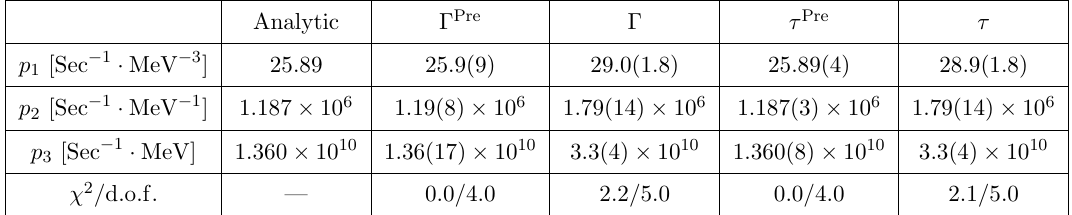
Table 23 . The analytic computations and (cid:12)tting results of the parameters p 1 , p 2 , and p 3 . urations and con(cid:12)gurations in which the monopoles and anti-monopoles were added; then, we (cid:12)rst observed the e(cid:11)ects of the monopoles by calculating the physical quantities with these